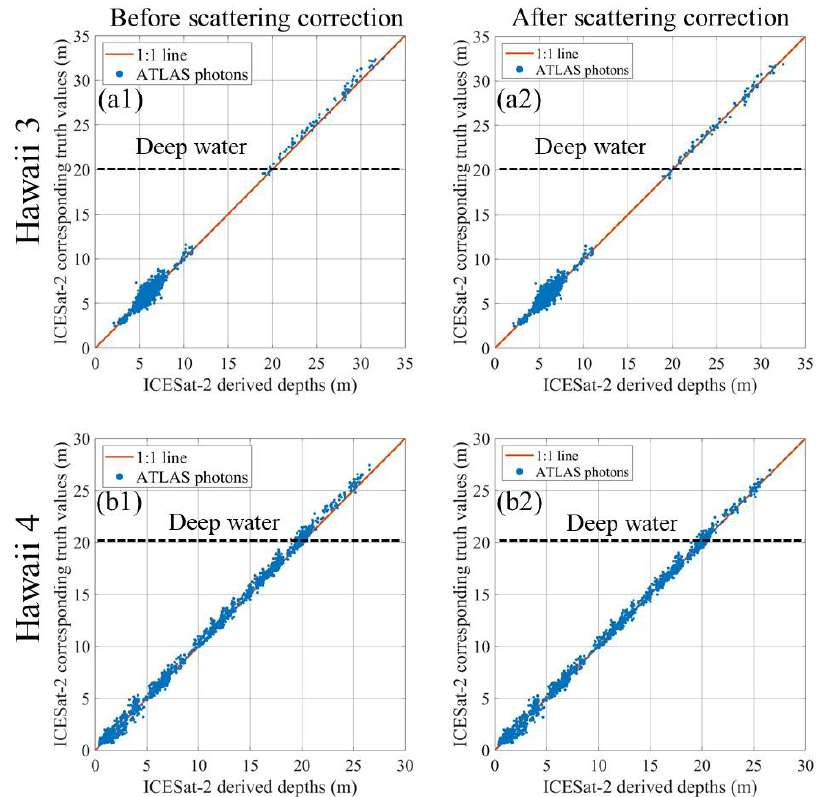
Figure 10. Comparisons between ICESat-2-derived depths and their corresponding truth values under the vertical datum of water depths at Hawaii. Two left subfigures ( a1 , b1 ) correspond to ICESat-2 points without water forward-scattering corrections, whereas ( a2 , b2 ) correspond to that with scattering corrections.